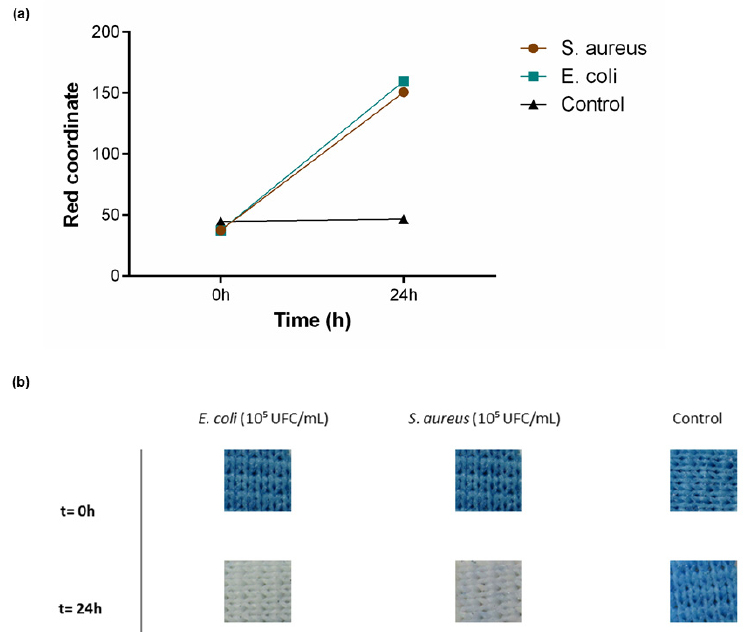
Figure 6. Bacterial sensing activity of polyester functionalised with Prussian blue (PB) at 1 g/L. ( a ) Shift in the red channel coordinate, measured through the RGB model, after incubation with S. aureus (10 5 CFU/mL) and E. coli (10 5 CFU/mL) for 24 h in TSA, (n = 3, ± SD). ( b ) Colour change displayed by the samples throughout the assay. Control is represented as the condition where the textiles were incubated only with TSA.